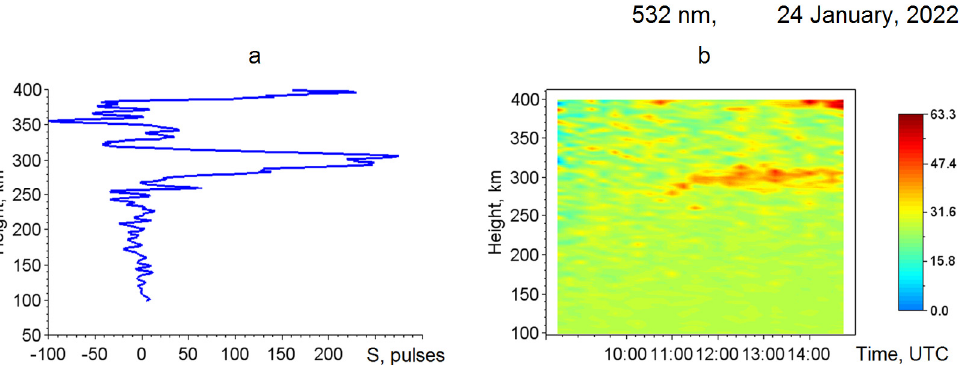
Figure 12. The total normalized signal Sn ( a ), spatiotemporal distribution of the normalized lidar signals with background noise subtracted for an altitude in the range of 100–500 km ( b ) obtained on 24 January 2022.